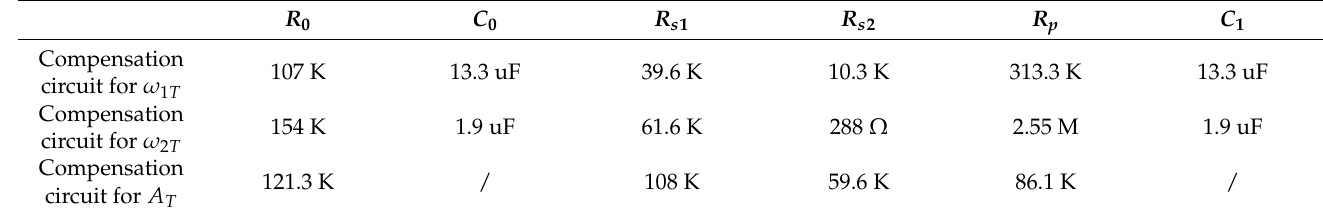
Table 3. Parameter fitting results of the temperature compensation circuits.